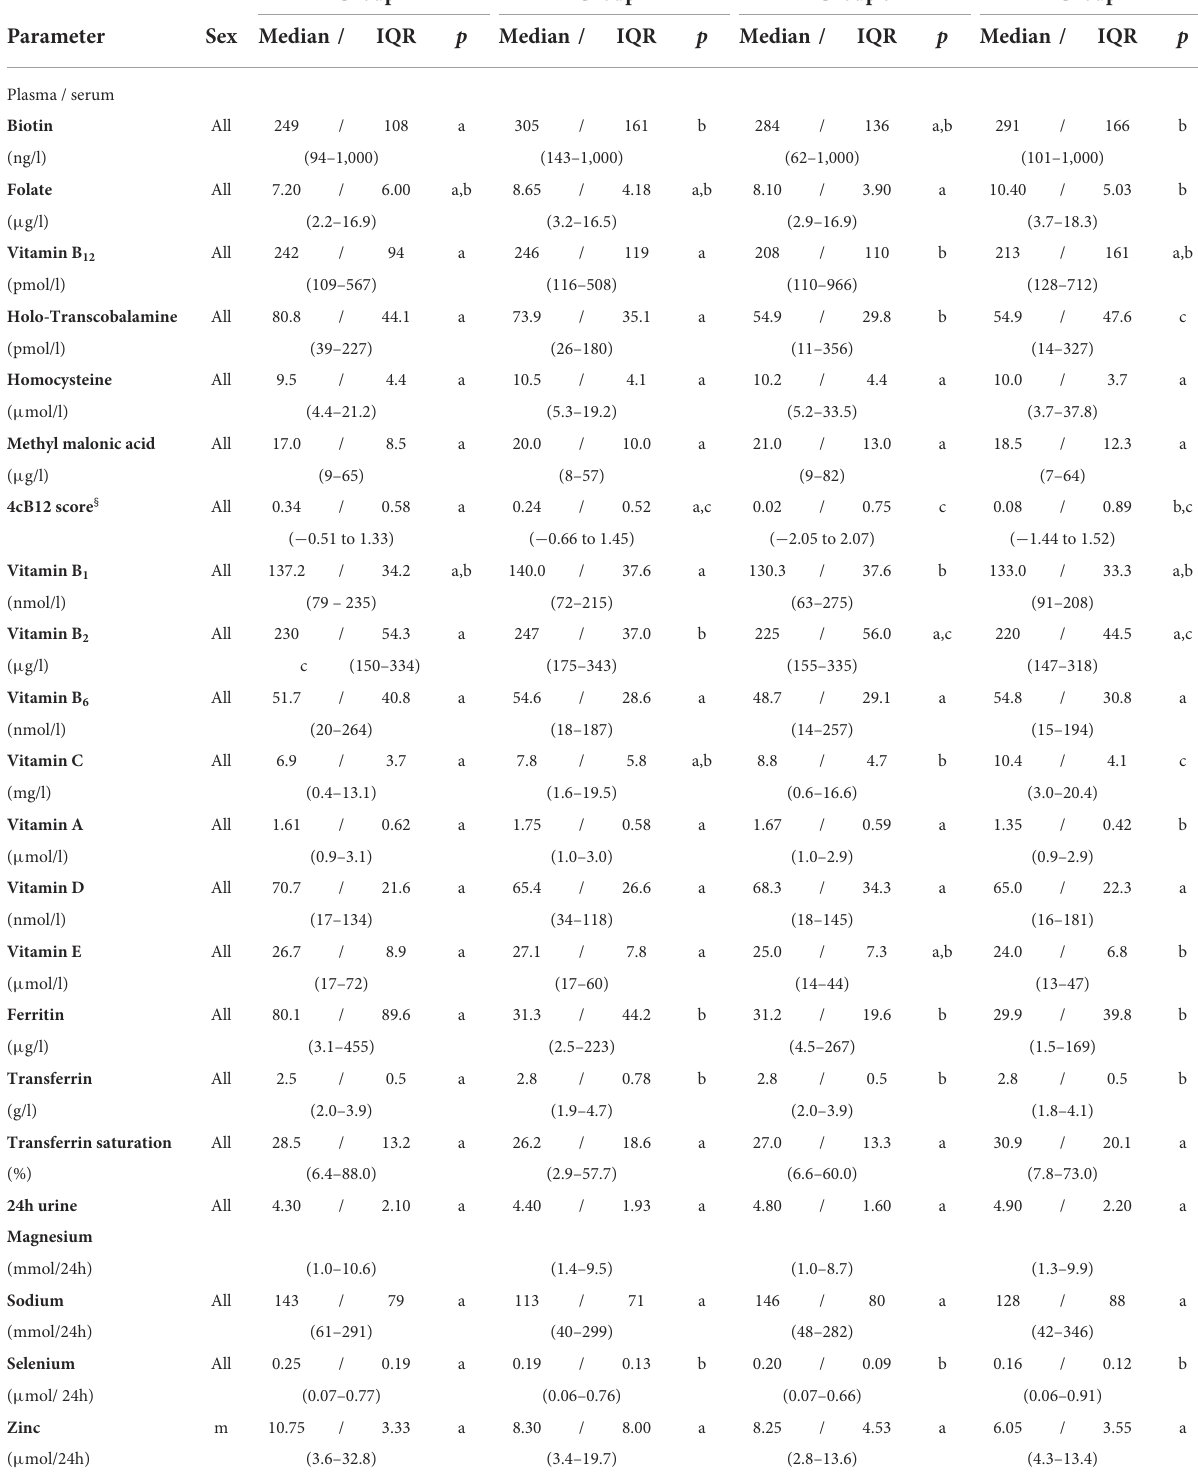
TABLE 6 Vitamins, minerals and trace elements in plasma/serum and 24h urine – NuEva-screening (Median / IQR; (Min -